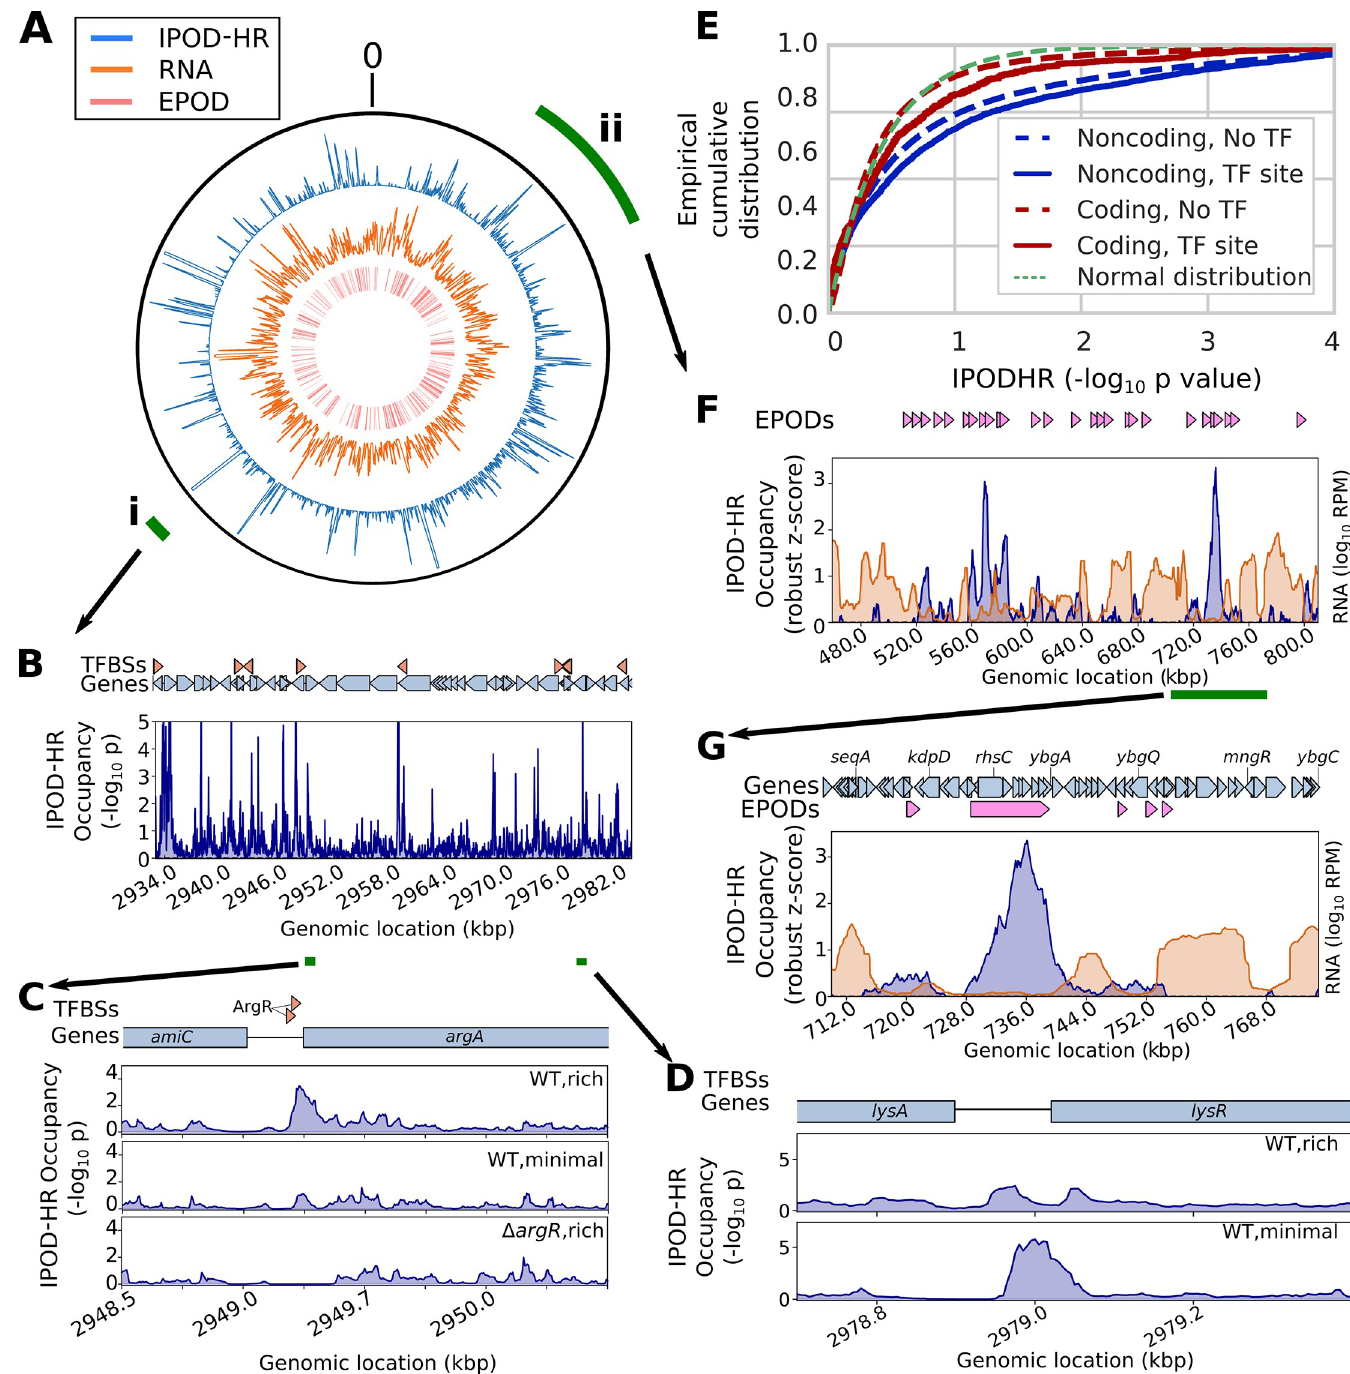
Fig 2. IPOD-HR profiles reveal rich high-resolution occupancy dynamics and large-scale structural features across the chromosome. (A) Outer track: IPOD-HR occupancy (robust Z-scores, 5-kb moving average); middle track: total RNA read density (5-kb moving average); inner track: locations of inferred EPODs. The outer green wedges mark the portion of the chromosome shown in subsequent panels. The origin of the coordinate system is oriented at the top of the plot. All data in this figure are for the “WT,rich” condition unless otherwise noted. (B) IPOD-HR occupancy measured during growth in glucose RDM, in the vicinity of wedge i from panel A . Green segments below the genomic coordinates indicate the regions highlighted in panels C–D . (C) Condition-dependent occupancy changes at the ArgR binding sites upstream of argA . (D) Identification of condition-specific occupancy of a likely LysR binding site between lysA and lysR . (E) Cumulative histograms showing RNA polymerase ChIP-subtracted IPOD-HR occupancy in coding vs. noncoding regions and at sites that match known TFBSs from RegulonDB [7], compared with the curve that would be expected from a standard normal distribution of scores. Additional descriptive statistics and significance calls are given in S1 Table . (F) Occupancy (blue)